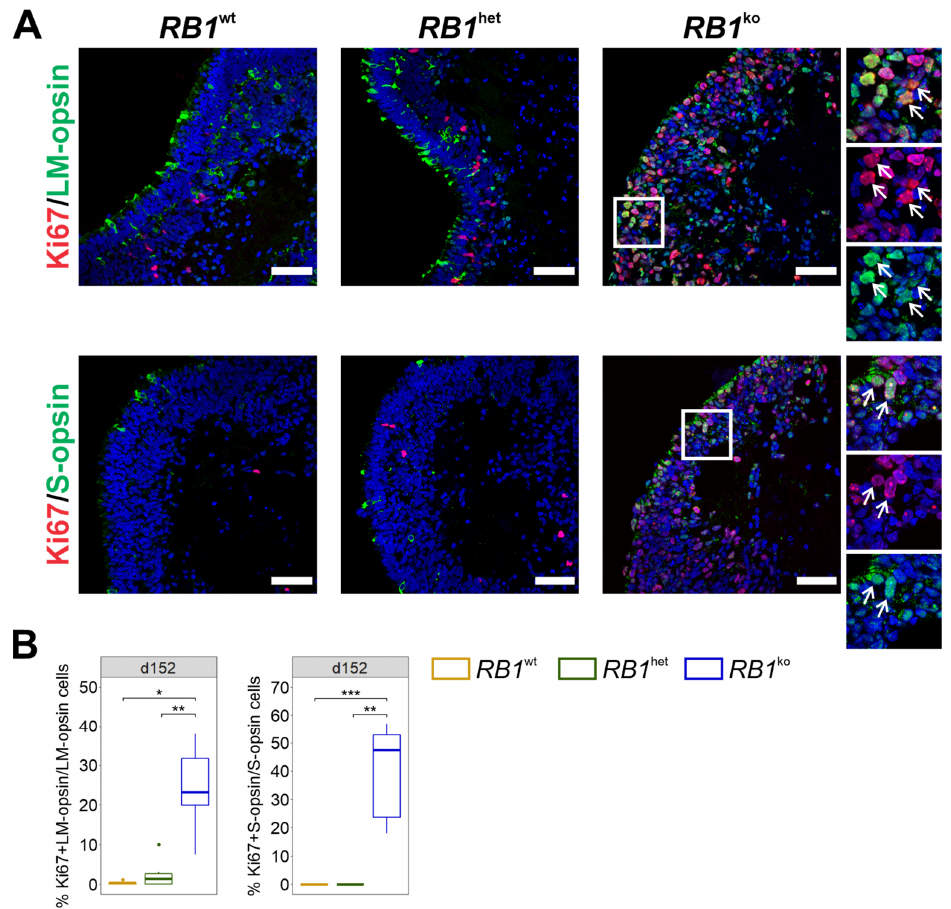
Figure 4. RB1 ko organoids exhibit proliferating LM- or S-opsin-positive photoreceptors. ( A ) Rep- resentative images of co-immunofluorescent staining of cone marker proteins LM-opsin or S-opsin (green) with Ki67 (red) at d152 of differentiation. Arrows indicate double-positive cells. Nuclei were counterstained with DAPI (blue). Scale bar 50 μ m. ( B ) Quantification of cells staining positive for cone marker proteins and Ki67. The percentage of double-positive area normalized to cone marker-positive area is given. * p ≤ 0.05, ** p ≤ 0.01, *** p ≤ 0.001.